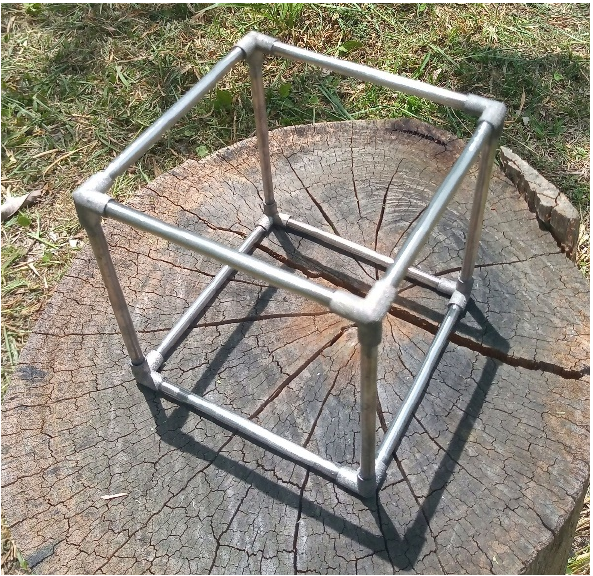
Figure 3. Example of the actual CubeSat structure ready for the welds. Each edge measures 100 mm.